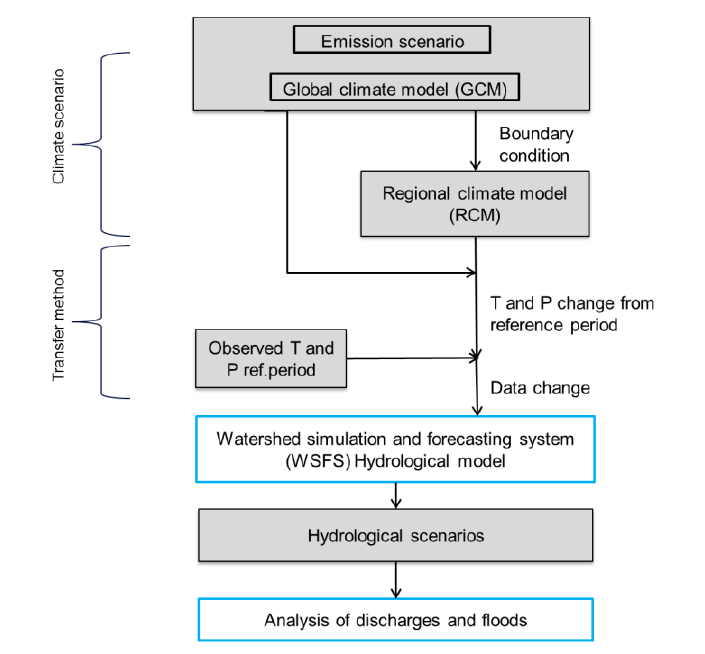
Figure 2. Schematic figure of the method used in flood assessment in Finland based on the data presented in Figure 11 originally published in Veijalainen et al. [28]. Grey boxes indicate input/output data and white boxes research methods.